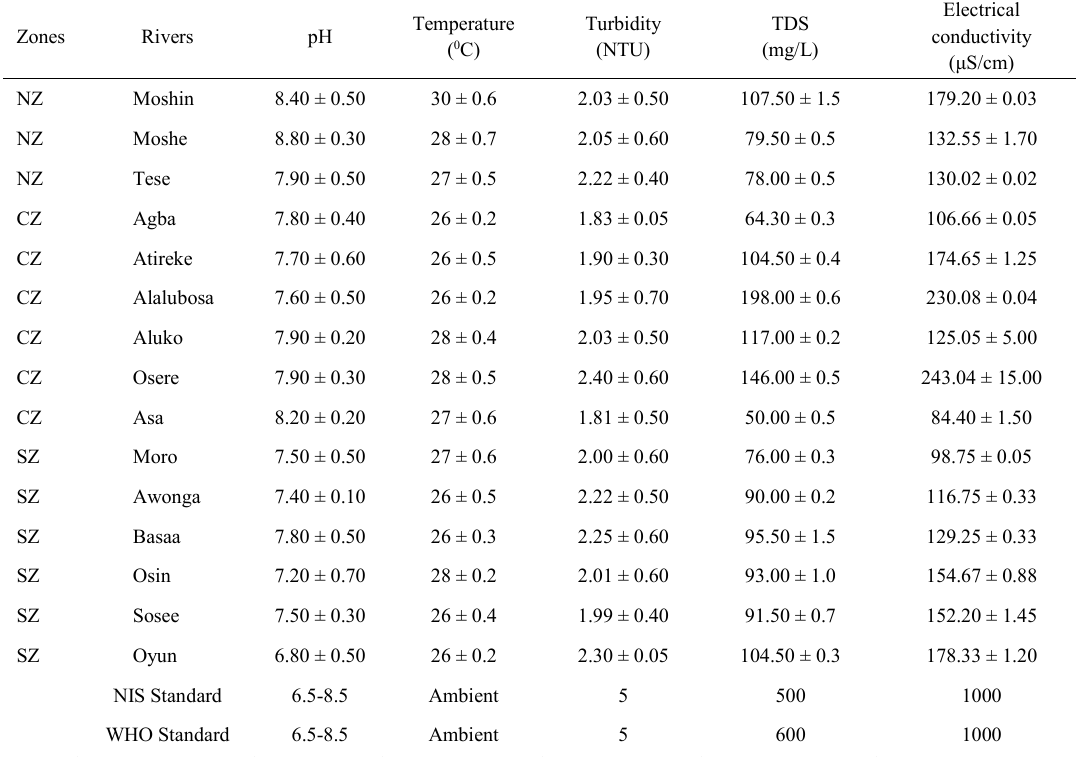
Table 1: Mean distribution of some physical parameters in the study area during the dry